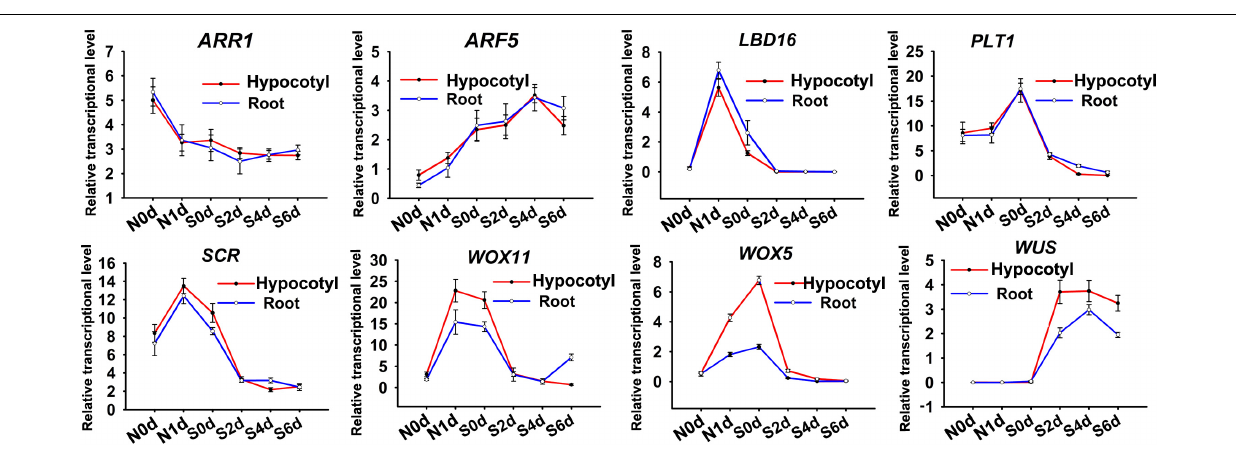
Frontiers in Plant Science |